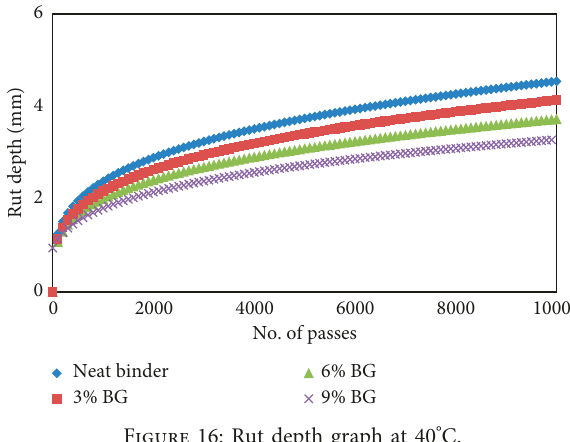
Figure 16: Rut depth graph at 40 ° C.